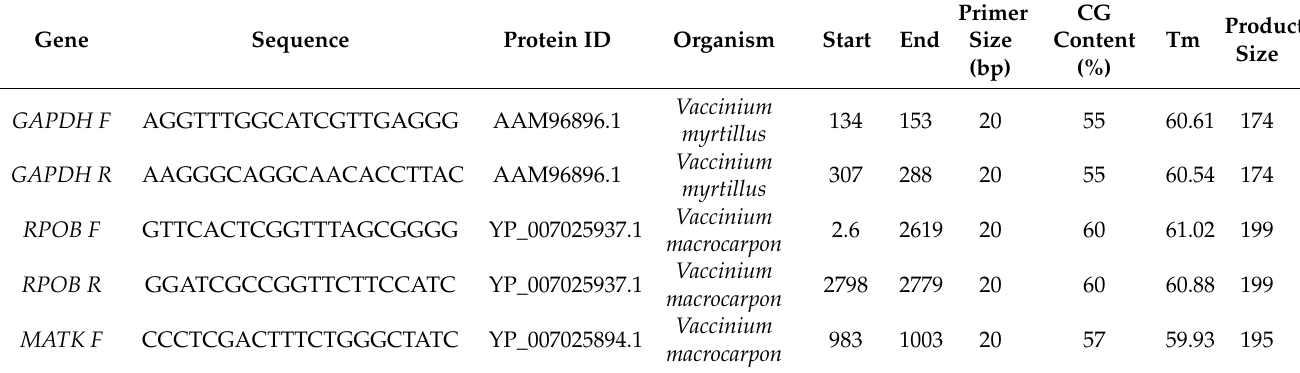
Table 2. Specific primers from plants of Vaccinium genus.